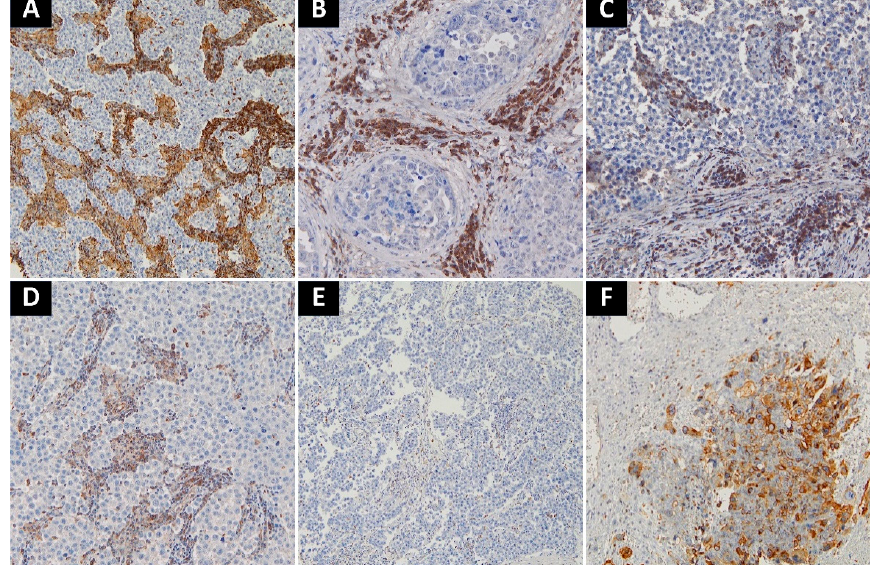
Figure 3. Representative examples of VISTA-staining. ( A ) Seminoma with intense VISTA staining in TAICs in fibrovascular septa; ( B ) Embryonal carcinoma with intense staining in TAICs; ( C ) Scattered VISTA-positive TAICs in stroma surrounding embryonal carcinoma; ( D ) Moderate amount of VISTA-positive TAICs in fibrovascular septa of seminoma; ( E ) Single VISTA-positive TAICs in seminoma; ( F ) VISTA-positive. choriocarcinoma cells in mixed malignant germ cell tumor. Abbreviations: VISTA: V-domain Ig suppressor of T cell activation; TAICs: tumor-associated immune cells. Table 2. Associations between PD-L1 expression on TAICs and dichotomized clinicopathological